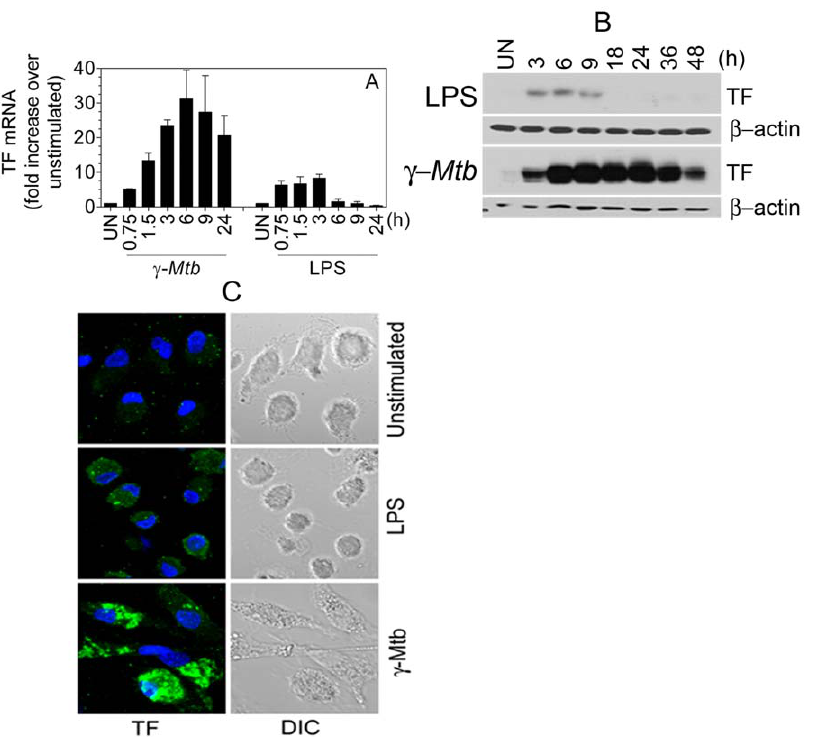
Figure 3. Expression of TF mRNA and protein synthesis in macrophages in response to treatment with c -Mtb . ( A ) MDMs in 6-well plates were stimulated with c - Mtb H37Rv (10 m g/ml) or LPS (100 ng/ml) for varying time periods in RPMI complete medium. Total RNA was isolated and subjected to real-time qPCR analysis in triplicates. GAPDH was used as an internal control and data were normalized to the internal control. TF mRNA increase was depicted as fold increase over unstimulated cells ( B ) Immunoblotting of MDM cell lysates harvested following c - Mtb H37Rv (10 m g/ml) or LPS (100 ng/ml) treatment for varying times with TF9C3 mAb. ( C ) Immunofluorescence confocal microscopy with TF polyclonal antibodies (10 m g/ ml) showing increased macrophage TF expression upon c - Mtb stimulation as compared to control and LPS stimulation. Data are mean 6 SEM (n=3)